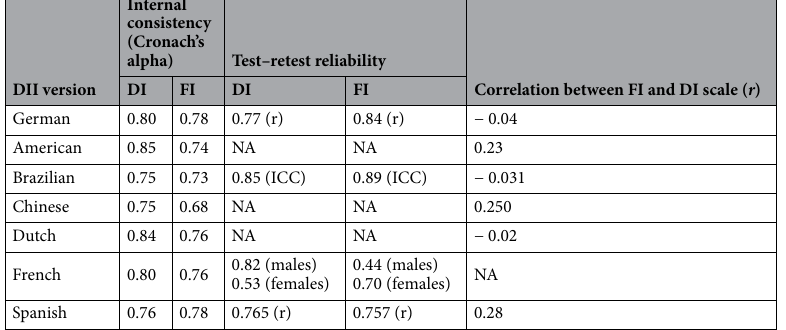
Table 3. Comparison of DII psychometric properties across validation studies. DI dysfunctional impulsivity subscale, FI functional impulsivity subscale, NA not available, r Pearson correlation, ICC intraclass correlation